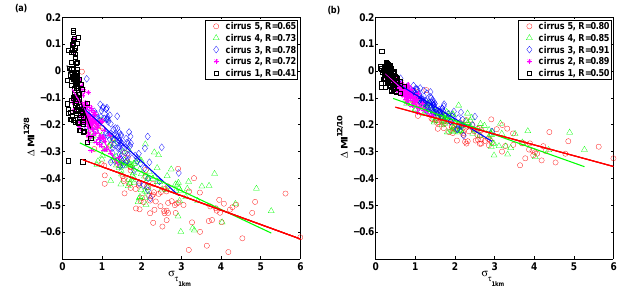
Figure 6. Microphysical index differences (cid:49) MI 12 / 8 (a) and (cid:49) MI 12 / 10 (b) as a function of the standard deviation of the optical thickness, σ τ , for cirrus cases 1 ( τ c = 0 . 45 , ρ τ = 0 . 7), 2 ( τ c = 1 km Figure 7. Errors on the retrieved effective diameter (cid:49)D eff, 1 km 0 . 90 , ρ τ = 0 . 7), 3 ( τ c = 1 . 80 , ρ τ = 0 . 7), 4 ( τ c = 1 . 80 , ρ τ = 1 . 1) as a function of the standard deviation of the optical thickness, and 5 ( τ c = 1 . 80 , ρ τ = 1 . 5) with D eff = 9.95µm for the five cirrus. σ τ , for cirrus cases 1 ( τ c = 0 . 45 , ρ τ = 0 . 7), 2 ( τ c = 0 . 90 , ρ τ = R represents the correlation coefficient between (cid:49) MI and σ τ . 1 km 1 km 0 . 7), 3 ( τ c = 1 . 80 , ρ τ = 0 . 7), 4 ( τ c = 1 . 80 , ρ τ = 1 . 1) and 5 ( τ c = 1 . 80 , ρ τ = 1 . 5) with D eff = 9.95µm for the five cirrus. Effective diameters are estimated using the split-window